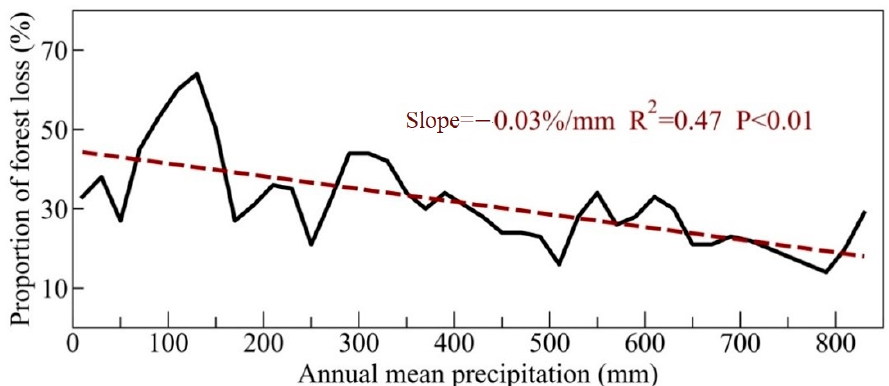
Figure 11. The linear regression analysis between the annual precipitation and the ratio of forest loss.